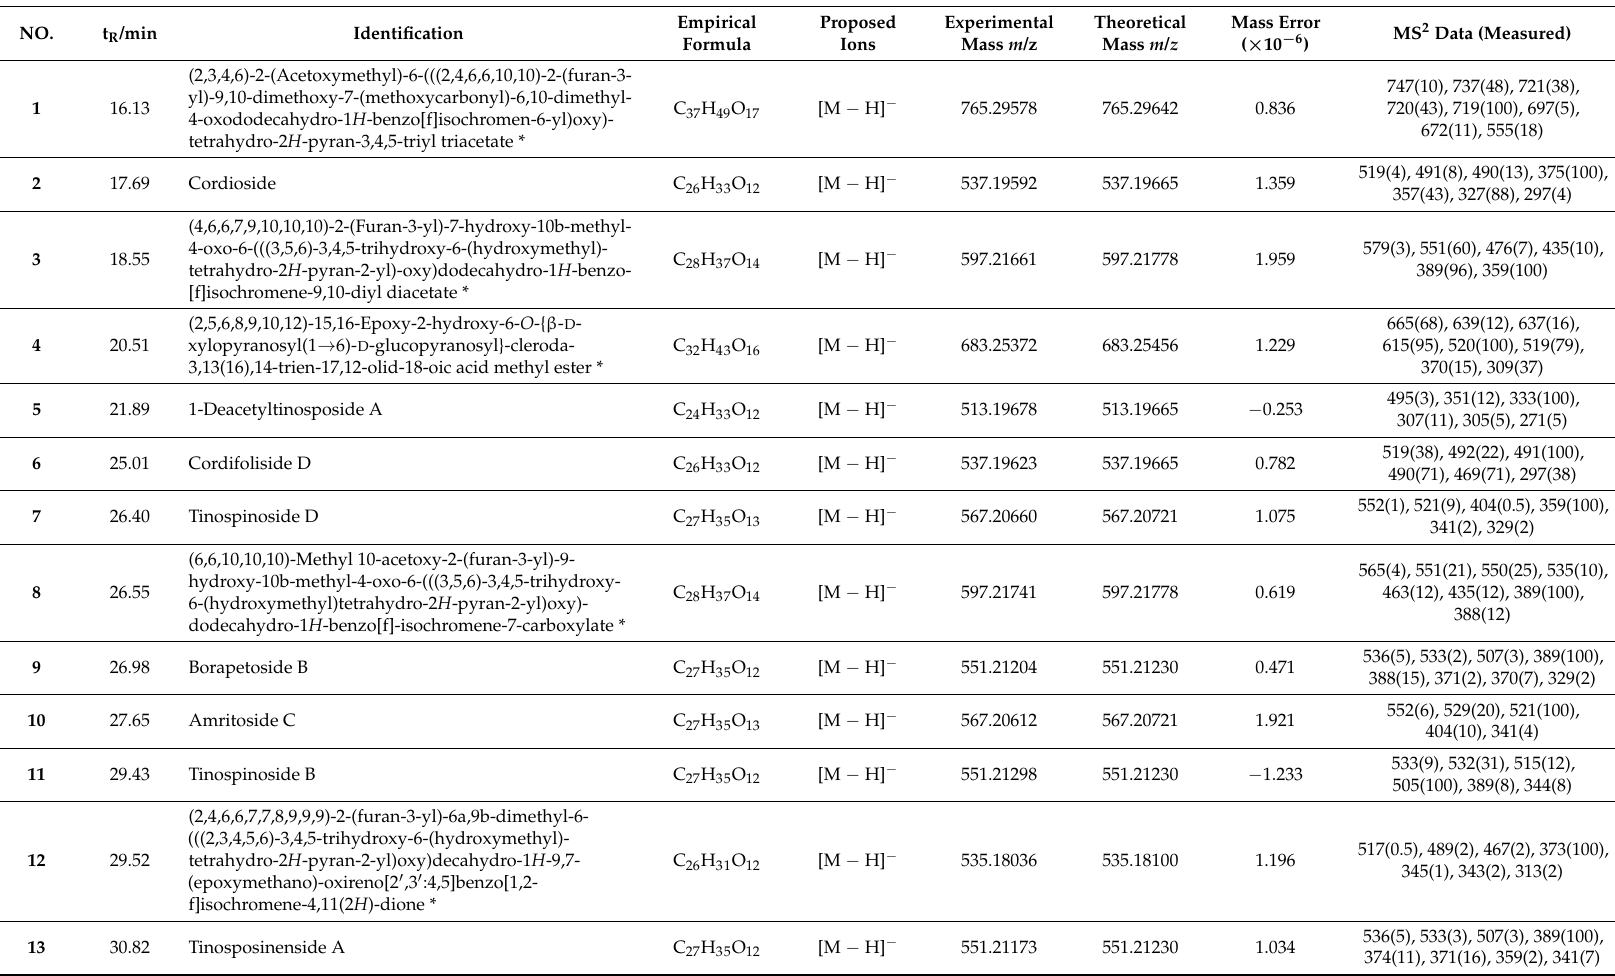
Table 1. Summary of chemical constituents identified in Tinospora sinensis by